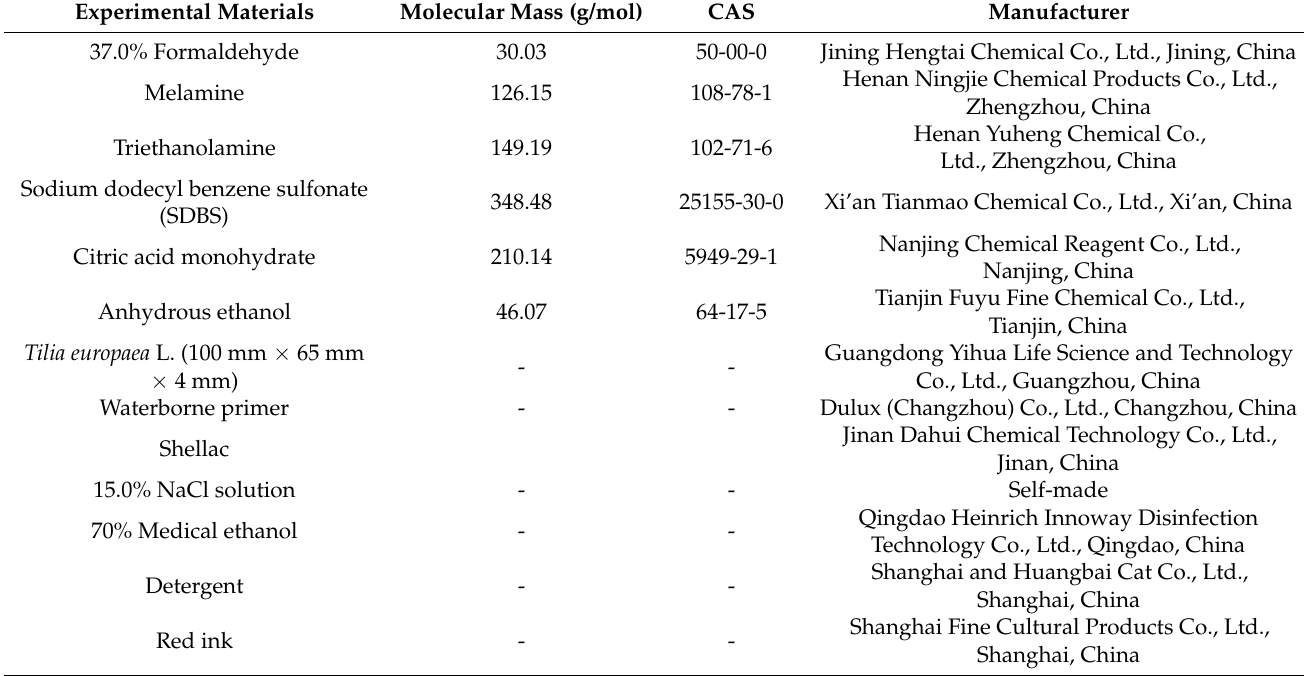
Table 1. List of experimental